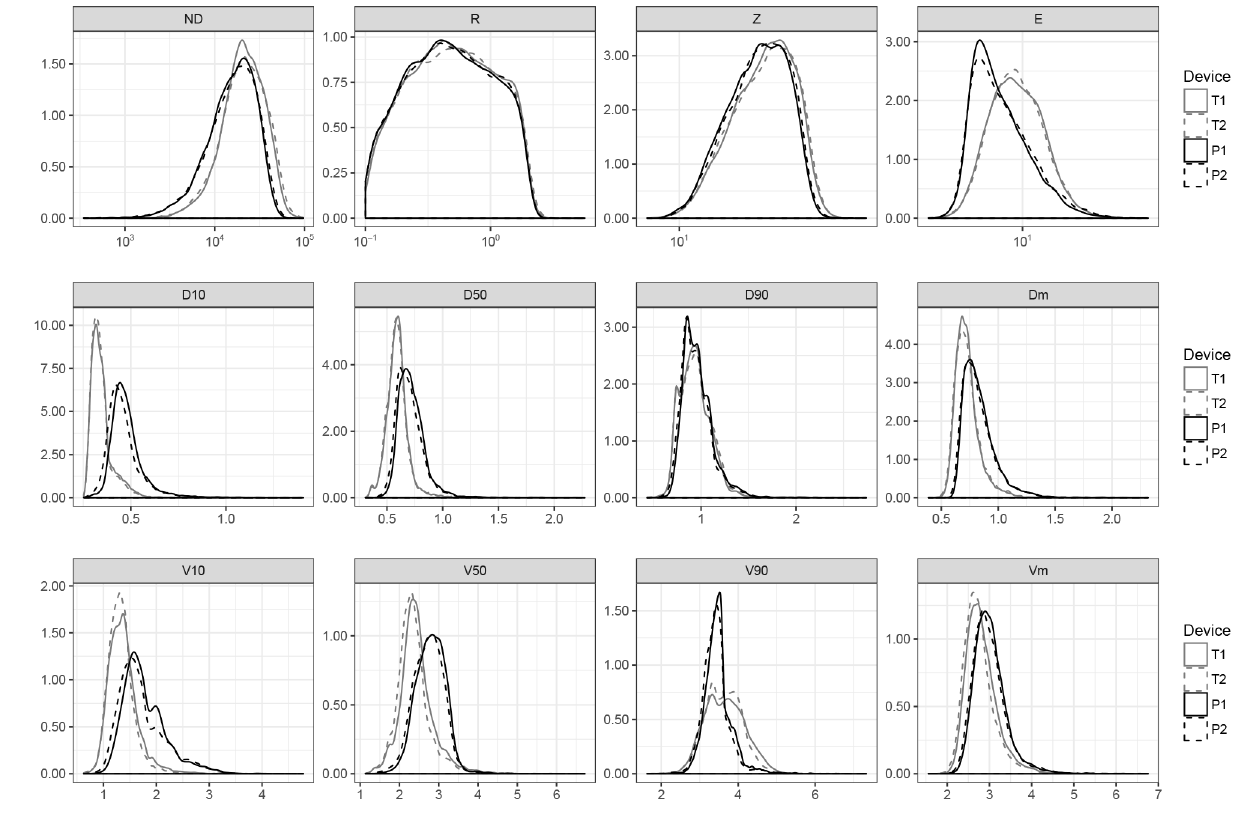
Figure A4. Kernel density plots for low rainfall intensities (0.1 <I < 2mmh − 1 ).